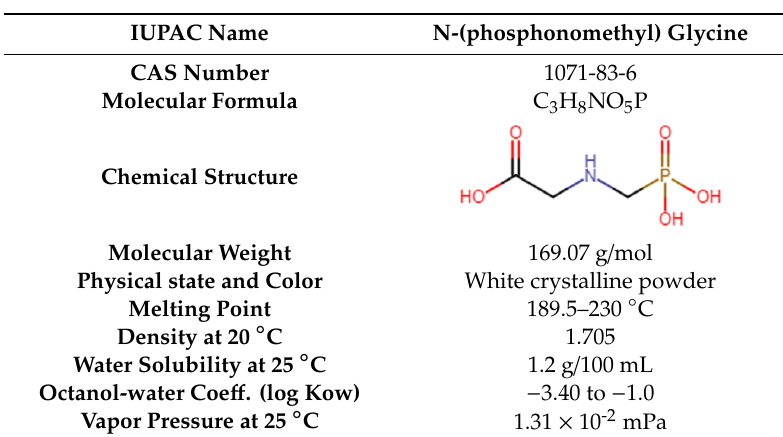
Table 1. Chemical and physical properties of glyphosate.